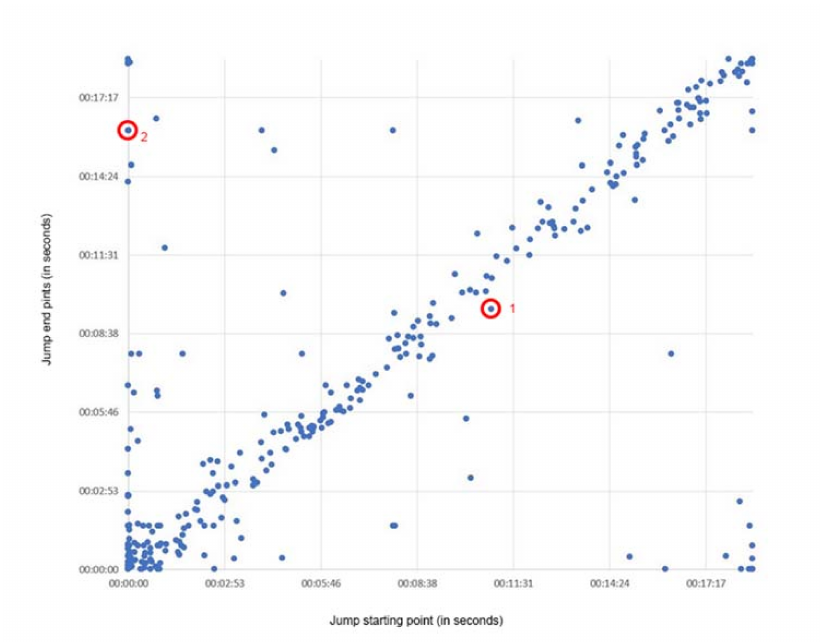
Figure 3. A scatter plot representing skipping behaviour for a typical educational video. Two jumps have been highlighted. Jump 1 represents a short backwards jump. Jump 2 represents a jump from the beginning of the video to the 16:04 mark.